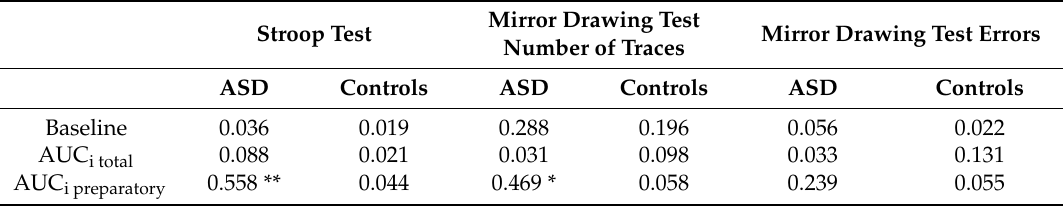
Table 2. Pearson correlations between testosterone (T) and cognitive performance for mothers of ASD offspring and controls. * p < 0.05, ** p < 0.01. Mirror Drawing Test Mirror Drawing Test Errors Stroop Test Number of Traces ASD Controls ASD Controls ASD Controls Baseline